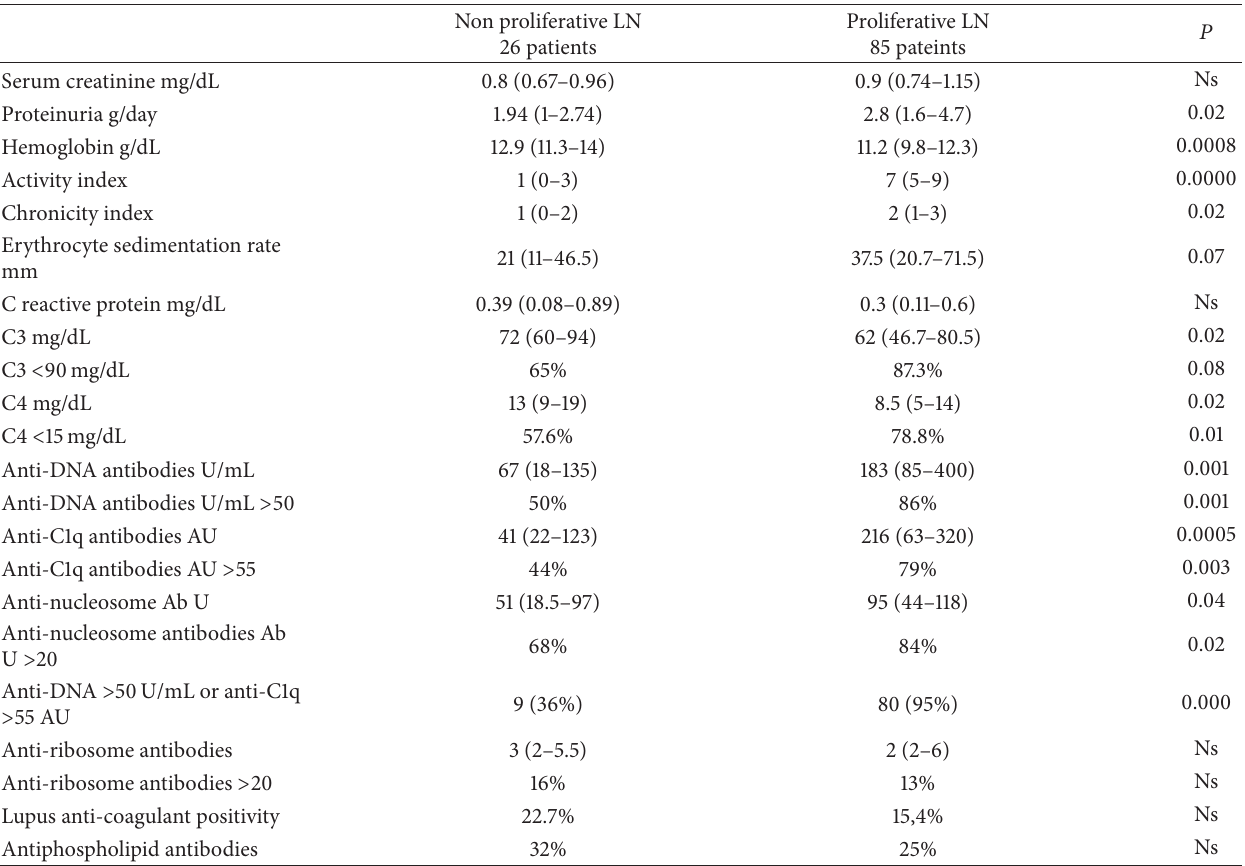
Table 2: Comparison of clinical and immunological features between nonproliferative forms (class II + class V) and proliferative forms (class III + class IV) lupus